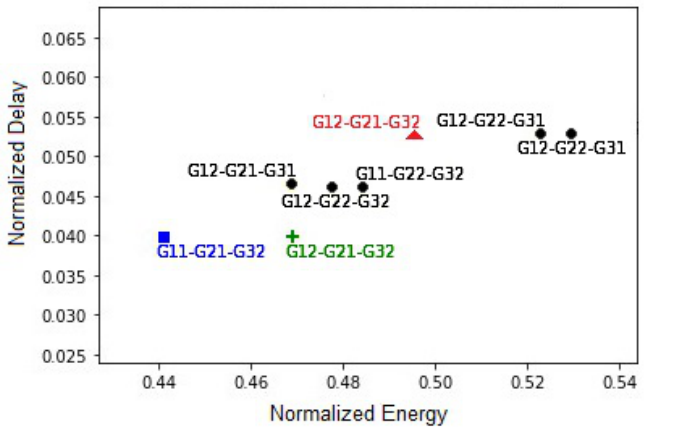
Figure 12. Representations of all sensor group combinations with their respective normalized delay and energy